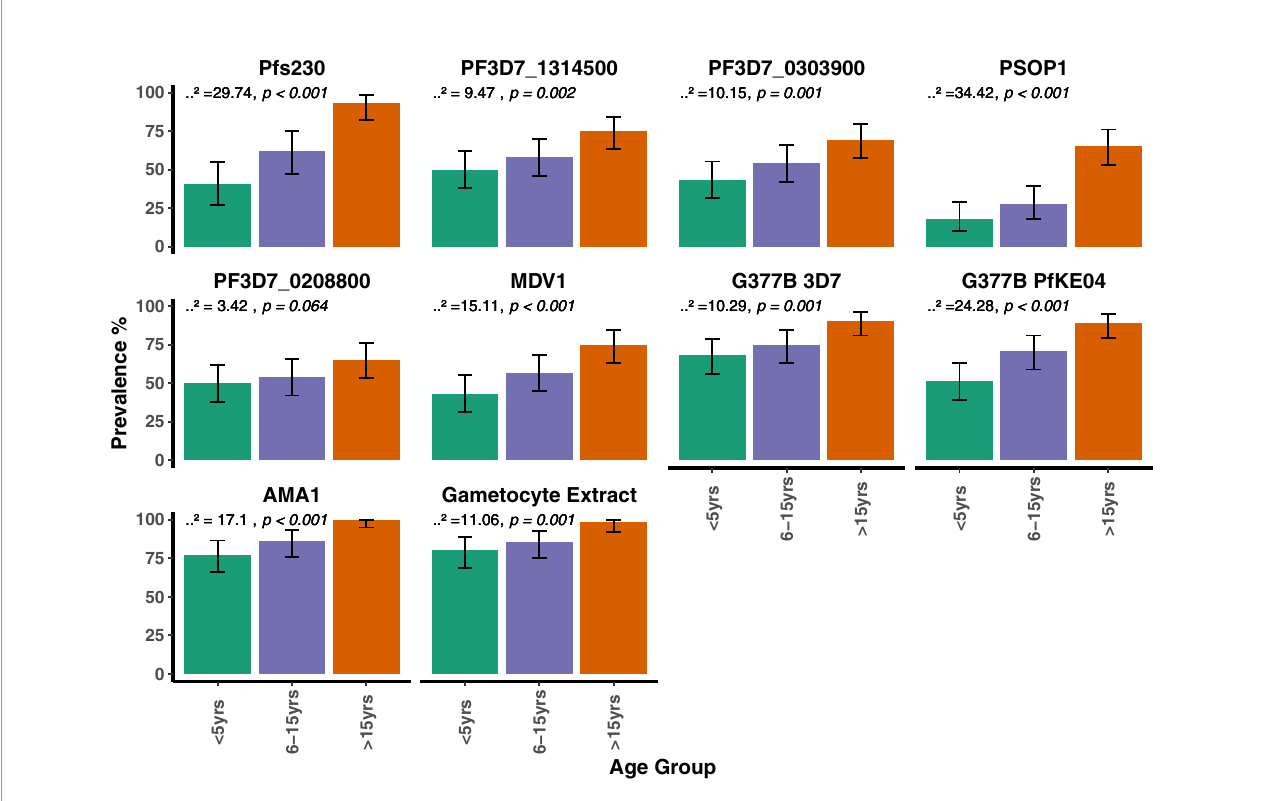
FIGURE 3 | Seroprevalence to the candidate antigens, AMA1 and gametocyte extract strati fi ed by age group in the AFIRM Cohort. Bar plots showing the prevalence of antibodies to the candidate antigens, AMA1 and gametocyte extract within the different age categories. The Cochran-Armitage test for trend was used to analyze the relationship between seroprevalence and age; p values are presented at the top of each panel. Error bars show 95% binomial con fi dence intervals (Clopper – Pearson interval).